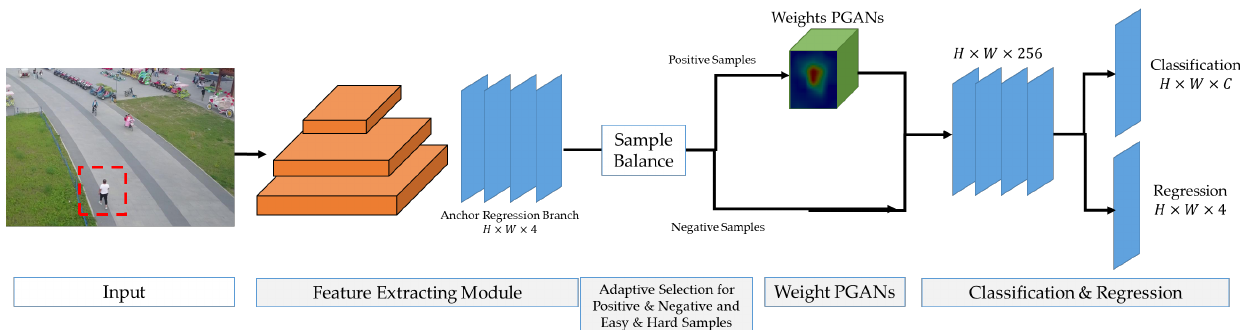
Figure 1. Framework of object detection from images captured by drones.